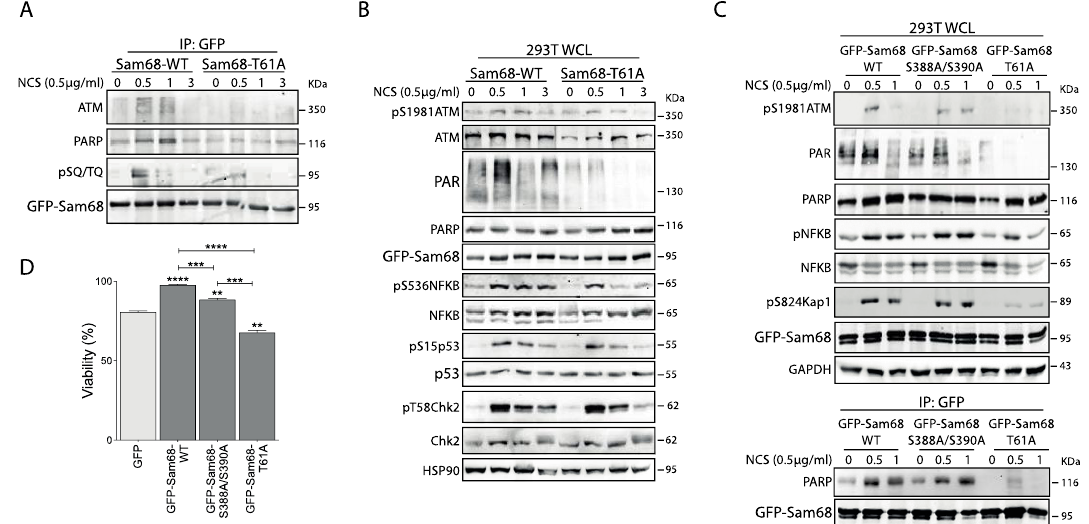
Figure 4. Sam68 phosphorylation on T61 is necessary for NF- κB activation and Sam68 -PARP inter- action upon DDR induction. ( A , B ) HEK293T cells were transiently transfected with fusion protein with either wild-type, GFP-Sam68 WT , or mutant lacking threonin 61 phosphorylation site, GFP- Sam68 T61A , and treated, or not, with NCS (500 ng/mL) and collected at the indicated time points (hours). ( A ) Representative western blot of protein extracts subjected to immunoprecipitation assay using anti-GFP antibody (IP: GFP) and immunoblotted with the indicated antibodies. ( B ) Repre- sentative western blot of total protein extracts (whole-cell lysate, WCL) and immunoblotted with the indicated antibodies. HSP90 was evaluated as loading control of total protein extracts. ( C ) Rep- resentative western blot of co-immunoprecipitation assay using anti-GFP (IP: GFP) antibody per- formed using WCL from HEK293T cells transfected with wild-type, GFP-Sam68 WT , and GFP- Sam68 T61A and GFP-Sam68 S388A/S390A mutants, and treated, or not, with NCS (500 ng/mL) for the indi- cated time points (hours). ( D ) Bar graph represents viability assay performed in HEK293T cells tran- siently transfected, or not (GFP), with the indicated GFP-Sam68 plasmids and treated with NCS (500 ng/mL) (mean ± s.d., n = 3). After 48 h, cell viability was assessed by the Cell Titer Glo Luminescent Assay and reported as the percentage of cell viability with respected to untreated cells (100% viabil- ity). Statistical significance (** p < 0.01, *** p < 0.001, **** p < 0 .0001; Student’s t -test) was evaluated with respect to GFP expressing cells treated with NCS (light grey bar). Brackets indicate additional statistical analysis of the indicated samples. 3.4. ATM Modulates the RNA Binding Affinity of Sam68 upon DDR Induction RBPs are increasingly recognized as key players in the DDR, and examples of coor- dinated regulation of DNA repair and RNA processing have been reported [6,7]. The RNA binding affinity of Sam68 and its activity in splicing and 3′ -end processing are modulated by phosphorylation [39,54 – 56]. Thus, we asked whether post-translational modification by ATM affects the RNA binding affinity of Sam68. To address this question, HEK293T cells were transiently transfected with GFP-Sam68 in the presence or absence of Flag-ATM (Figure 5A,B; WCL panels). RNA pulldown assays showed that Sam68 specifically inter- acts with synthetic poly-A RNA and that activation of the DDR pathway, by either over- expression of Flag-ATM or treatment with NCS, increased its binding affinity (Figure 5A; polyA-Seph panels). Concomitant overexpression of Flag-ATM and treatment with NCS further increased the affinity of GFP-Sam68 for synthetic Poly-A RNA (Figure 5A; polyA- Seph panels). Moreover, the effect of ATM was inhibited by treatment with KU55933 (Fig- ure 5B; polyA-Seph panels). To further test whether ATM-dependent phosphorylation was involved in this effect, we assessed the ability of Sam68 mutant isoforms to interact with poly-A synthetic RNA in the presence or absence of Flag-ATM (Figure 5C; WCL panels). Although all GFP-Sam68 mutants were able to bind RNA like the wild-type pro- tein, mutation of T61 abolished the increase in binding observed in cells co-transfected with Flag-ATM, whereas the GFP-Sam68 S388A/S390A double mutant behaved similarly to the wild-type protein (Figure 5C; polyA-Seph panels). These results suggest that, in addition